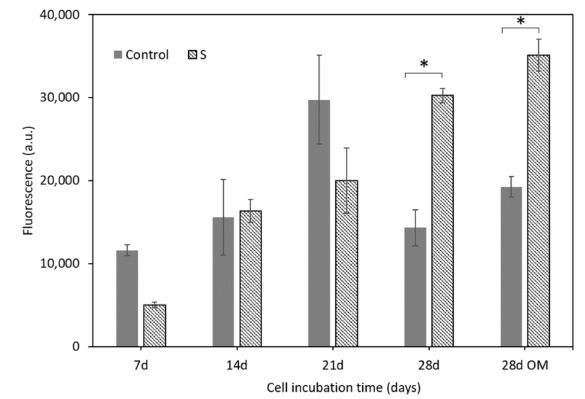
Figure 8. Metabolic activity of the ah-MSCs seeded on scaffold surfaces (S) and the positive control (Control) after different culture times in GM and OM. * denotes significant differences ( p < 0.05) between them at the same culture time.